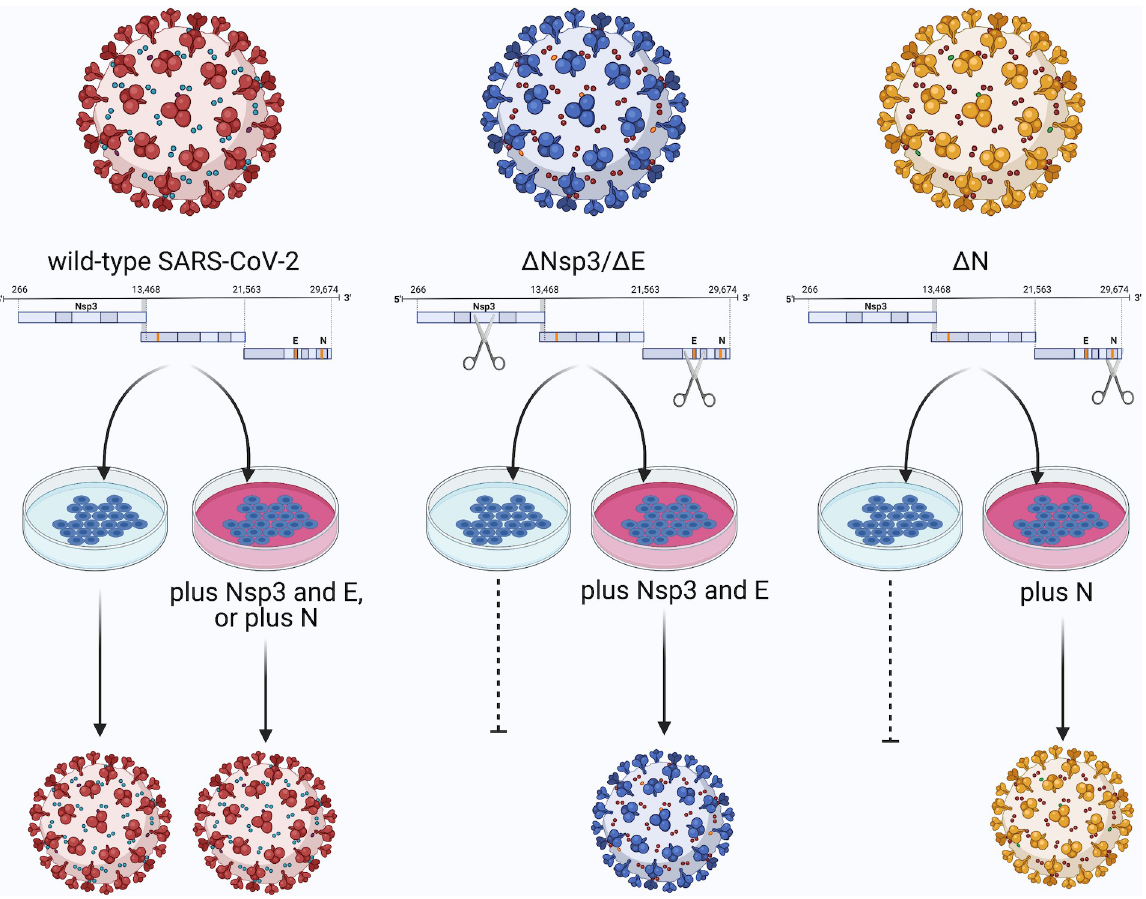
Fig 1. Generation of “biologically contained” single-cycle SARS-CoV-2 viruses using virus reverse genetics and “ trans -complementation”. Wild-type virus and gene-deleted viruses are produced through construction and manipulation of full-length virus genomes. Wild-type virus can infect any susceptible cells, and outcoming virus is fully infectious. However, gene-deleted viruses (loss of Nsp3, E, or N) can only replicate in cells providing the essential deleted gene products “in trans .” Cells expressing the genes in trans will generally only be found within the lab, and not in somebody’s respiratory tract, making these systems much safer and capable to be used outside of a BSL3 lab. Created with BioRender.com. BSL3, Biosafety Level 3; SARS-CoV-2, Severe Acute Respiratory Syndrome Coronavirus